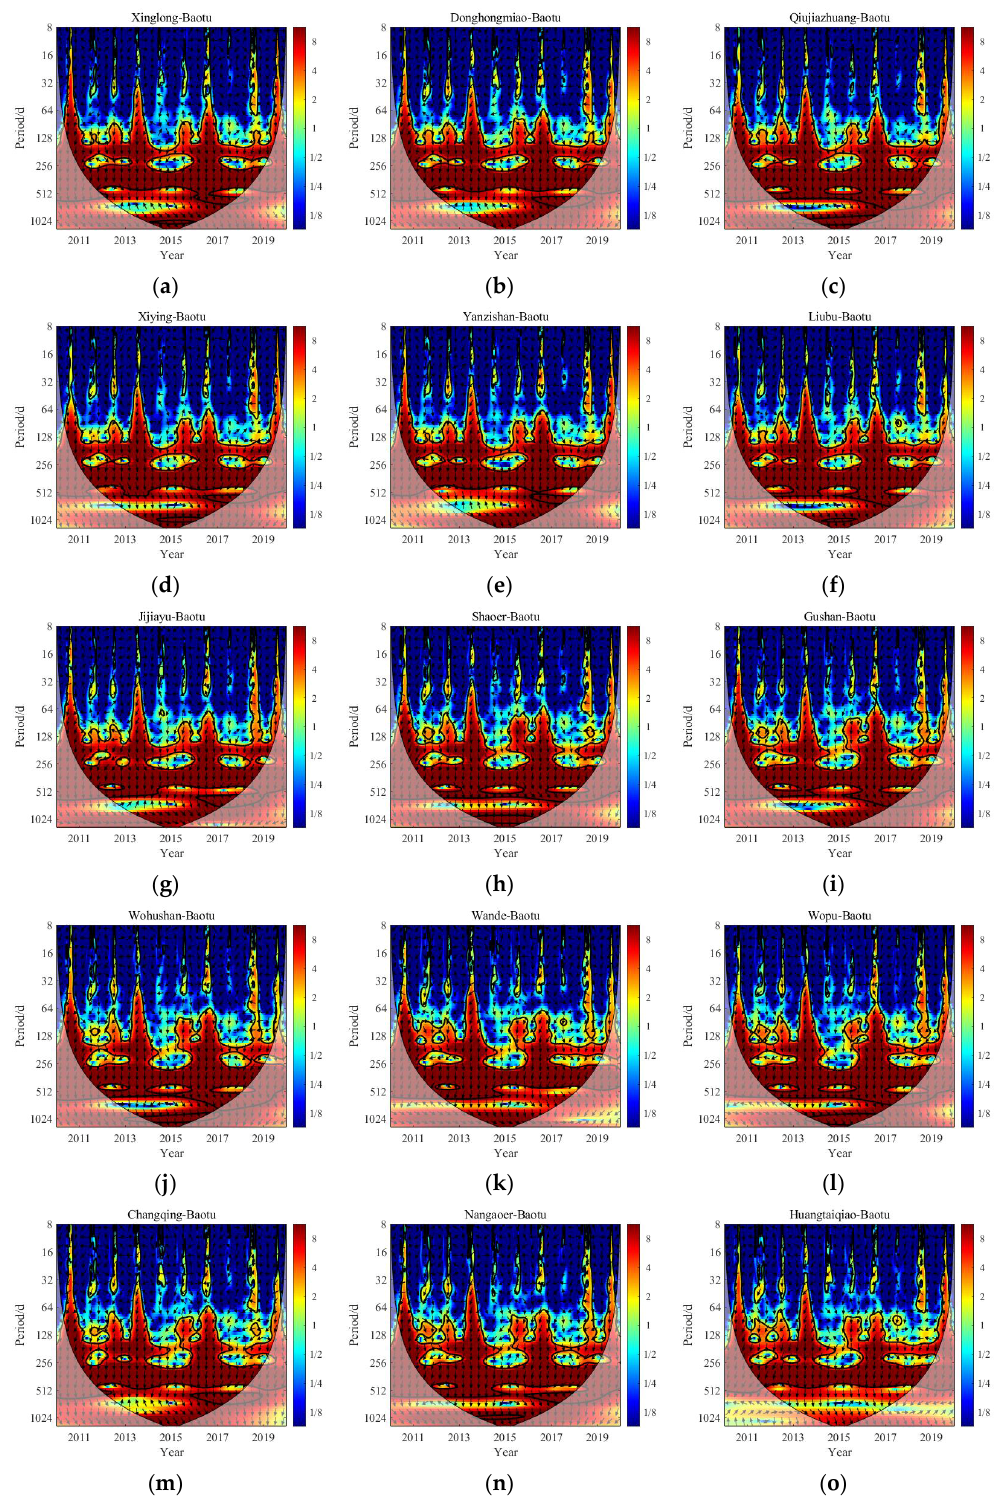
Figure 4. The XWTs of precipitation and BTS water level. ( a – o ) fifteen precipitation stations. The color scale indicates the cross wavelet power spectrum density corresponding to the different colors. The red and blue on the color scale represent the peak and valley values of power spectrum density, respectively. The thick black contour designates the 5% significance level against red noise, lighter shade represents the COI, and the arrows represents relative phase relationship of two time-series. The relative phase relationship of the two time-series is shown as arrows (with in-phase pointing right, anti-phase pointing left